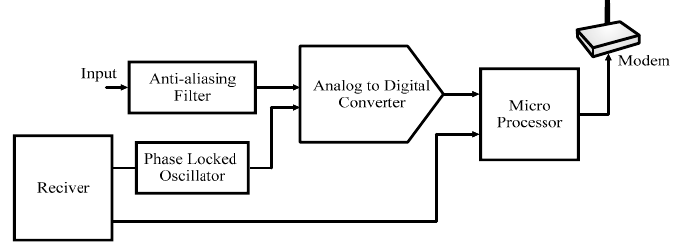
Figure 1. Block diagram of the basic phasor measurement unit (PMU) [10].